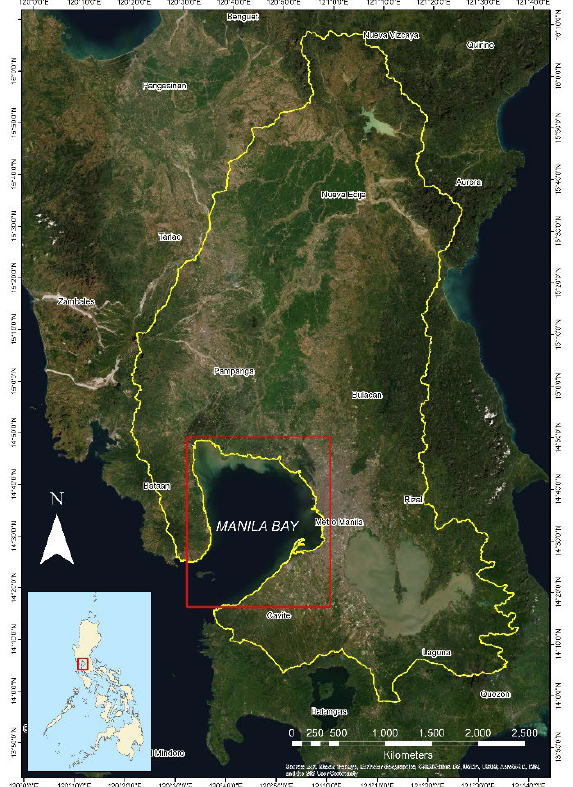
Figure 1 . Manila Bay and its watershed